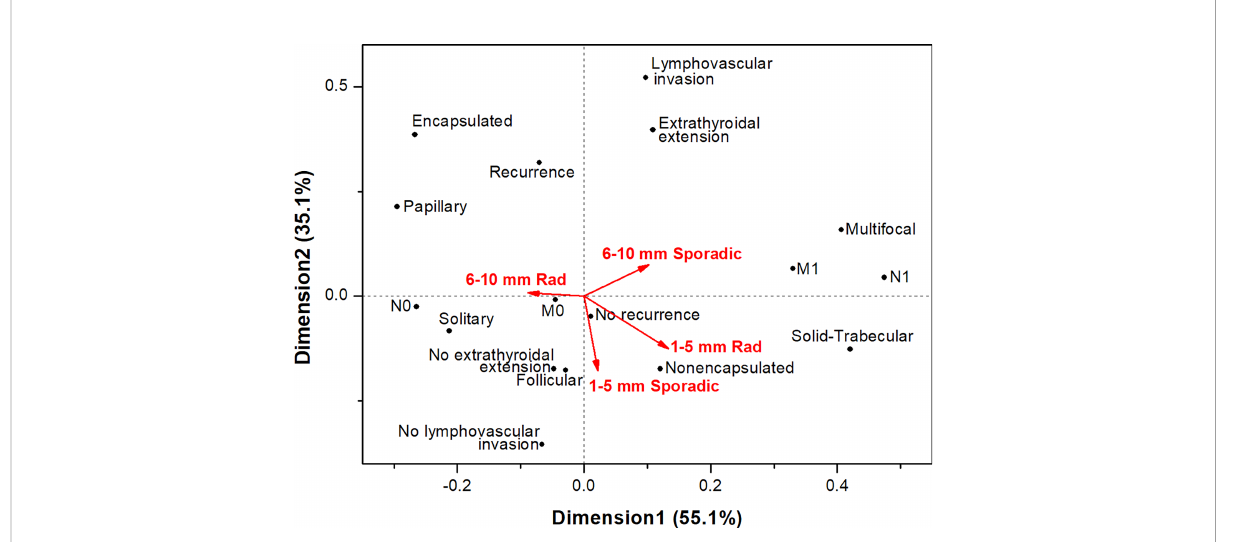
FIGURE 4 Correspondence analysis of the associations of papillary thyroid microcarcinomas of different etiology sized 1-5 mm and 6-10 mm with the major histopathological characteristics, tumor invasive features and